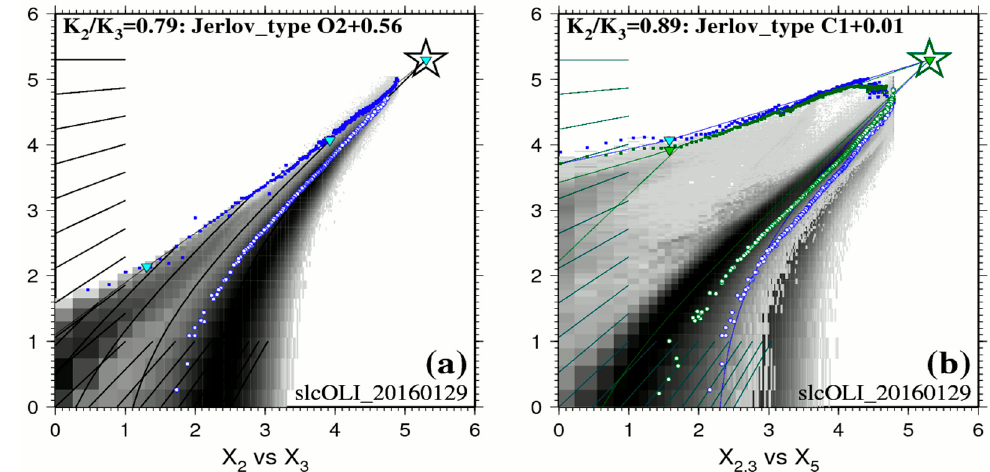
Figure A5. Plot of linearized calibration data (Equation (4)) for the whole of the 29 January 2016 scene. Bands 2, 3 and 5 are Blue, Green and Red, respectively. ( a ) is the calibration diagram of linearized Blue (X 2 ) and Green (X 3 ) and reports estimated K 2 /K 3 values with Jerlov water types. ( b ) is the calibration diagram for Blue (X 2 ), Green (X 3 ) and Red (X 5 ) bands respectively. The backdrop in shades of gray represents the bi-dimensional histogram for all image pixels (white ROI in Figure 1). Blue dots are the actual pixels used for BPL calibration, each referenced to its row/line position in the image. Small white circles represent the scatter of averaged bare land pixels, as a proxy for the Soil Line.